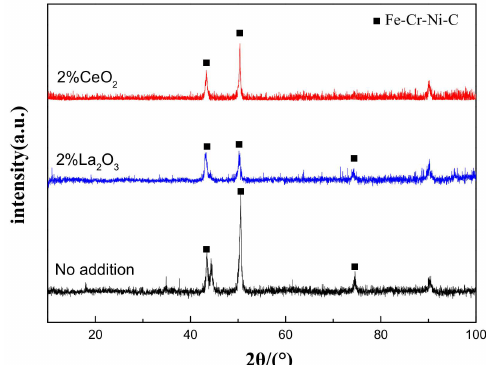
Figure 1. XRD patterns of laser-cladding layer on 316L stainless steel with or without the addition of rare earth